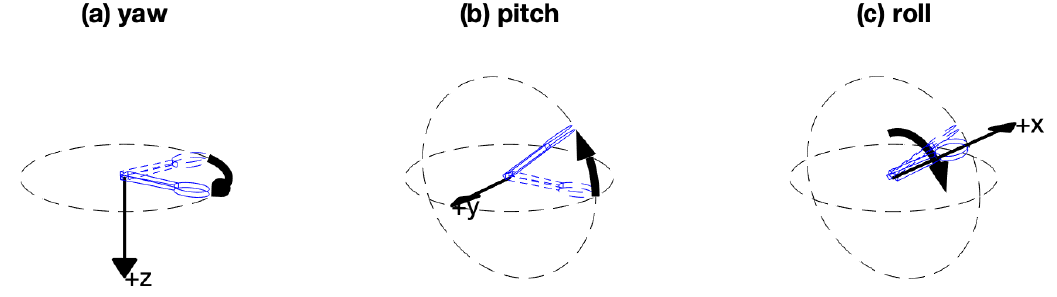
Figure 2. Yaw, Pitch and Roll angles (Tait–Bryan angles). The final orientation consists of three rotations in order: ( a ) yaw is the rotation about the z (up-down) axis; ( b ) pitch is the rotation about the rotated horizontal (y) axis; ( c ) roll is the rotation about the long axis (rotated x axis) of the spoon.